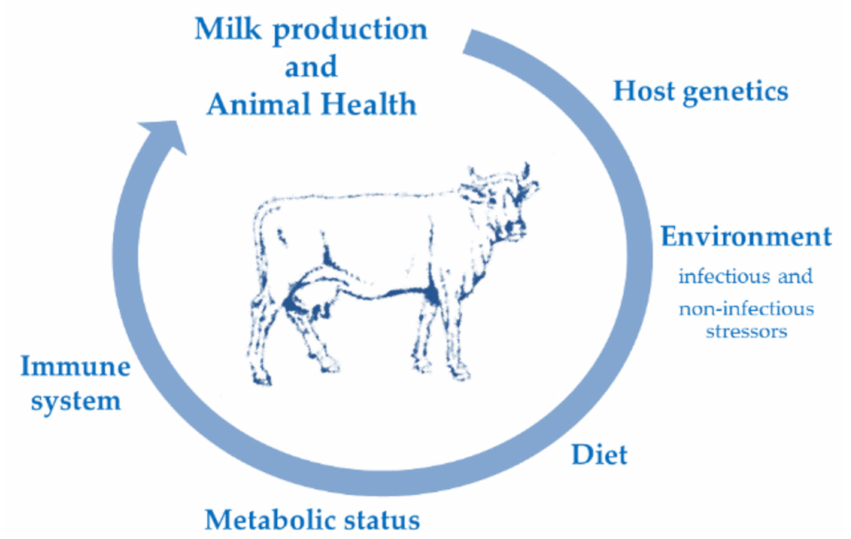
Figure 1. Milk production and animal health are influenced by and correlated to many factors such as genetics, environment stressors, diet, metabolic status, and the immunological system that all interact. During the periparturient period, dairy cows undergo a number of metabolic-, endocrine-, physiologic-, and immune-related changes, rendering cows more susceptible to disease and less e ffi cient. Health problems occurring before and after calving lead to severe negative e ff ects on the productive e ffi ciency of lactating cows. Reductions in the cow’s production and increased mortality rates are associated with periparturient health disorders. The costs of antimicrobial drugs, vaccines, labor, and preventive measures must be taken into consideration. During this period, immune